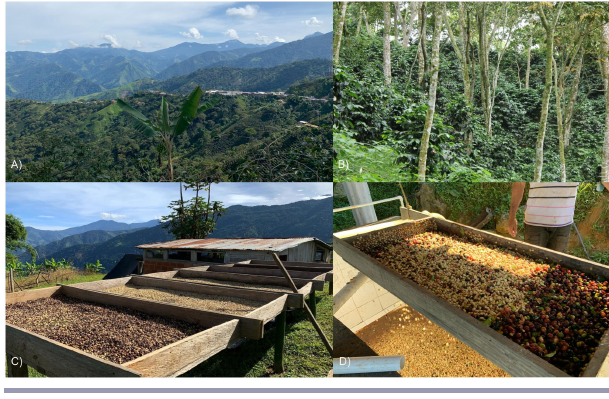
Fig. 2 . Coffee habitat and processing in Sierra Nevada de Santa Marta. (A) San Pedro community and coffee below ridge; (B) shade coffee farm; (C) coffee drying on a farm in San Pedro; (D) Coffee going through the de-pulping and washing